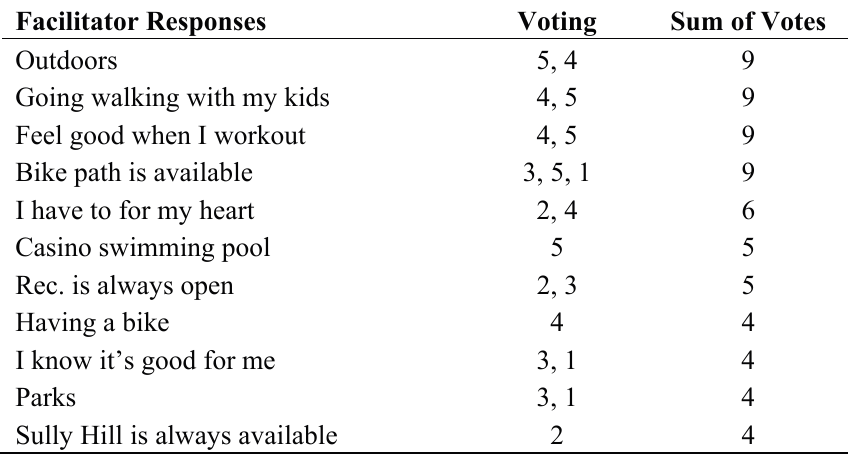
Table 2. Facilitators to meeting physical activity